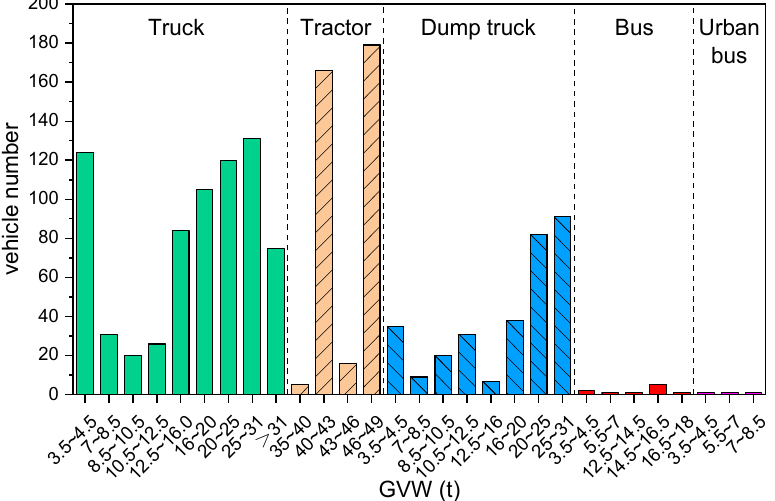
Figure 11. The number of vehicles included in this investigation.